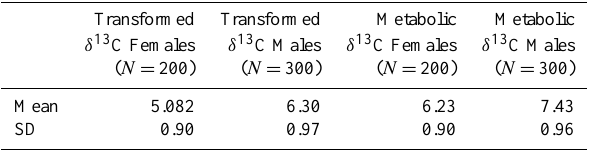
Table 4. Heikoop et al. (2000) correction factor results compar- ing transformed and metabolic skeletal δ 13 C of Porites panamensis colonies from Bahía de La Paz.